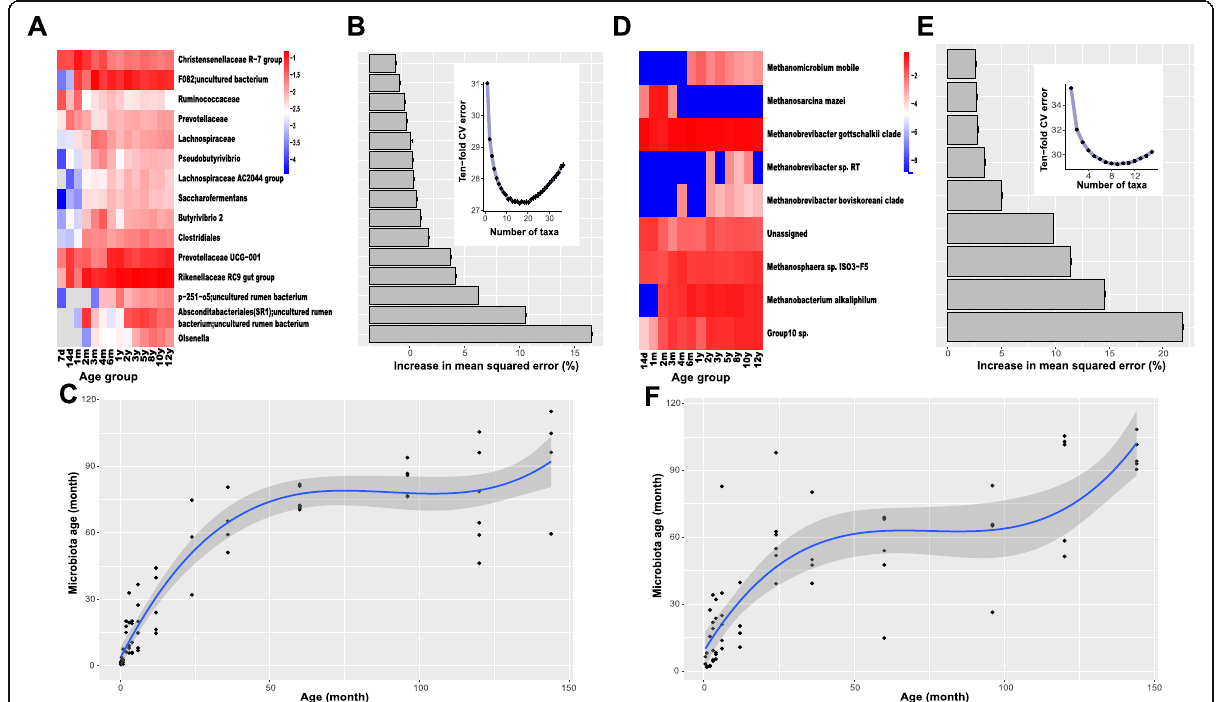
Fig. 4 Bacterial and archaeal taxonomic biomarkers for defining rumen microbiota maturation in grazing yaks. a, d Heatmap of the mean relative abundance of the age-discriminatory taxa against time of sampling for each age group. b, e Age-discriminatory taxa were identified by applying random forest regression of the relative abundances of taxa in rumen fluid against chronological age of grazing yaks. Importance was determined based on the percentage increase in the mean-squared error of the predicted microbiota age when the relative abundance values of each taxon were randomly permuted (mean importance ± sem., n = 100 replicates). The inset shows 10- fold cross-validation error as a function of the number of input taxa used to regress against the age of yaks in the training set, in order of variable importance. c, f Microbiota age predictions plotted against chronological age. The curve is a smoothed spline fit